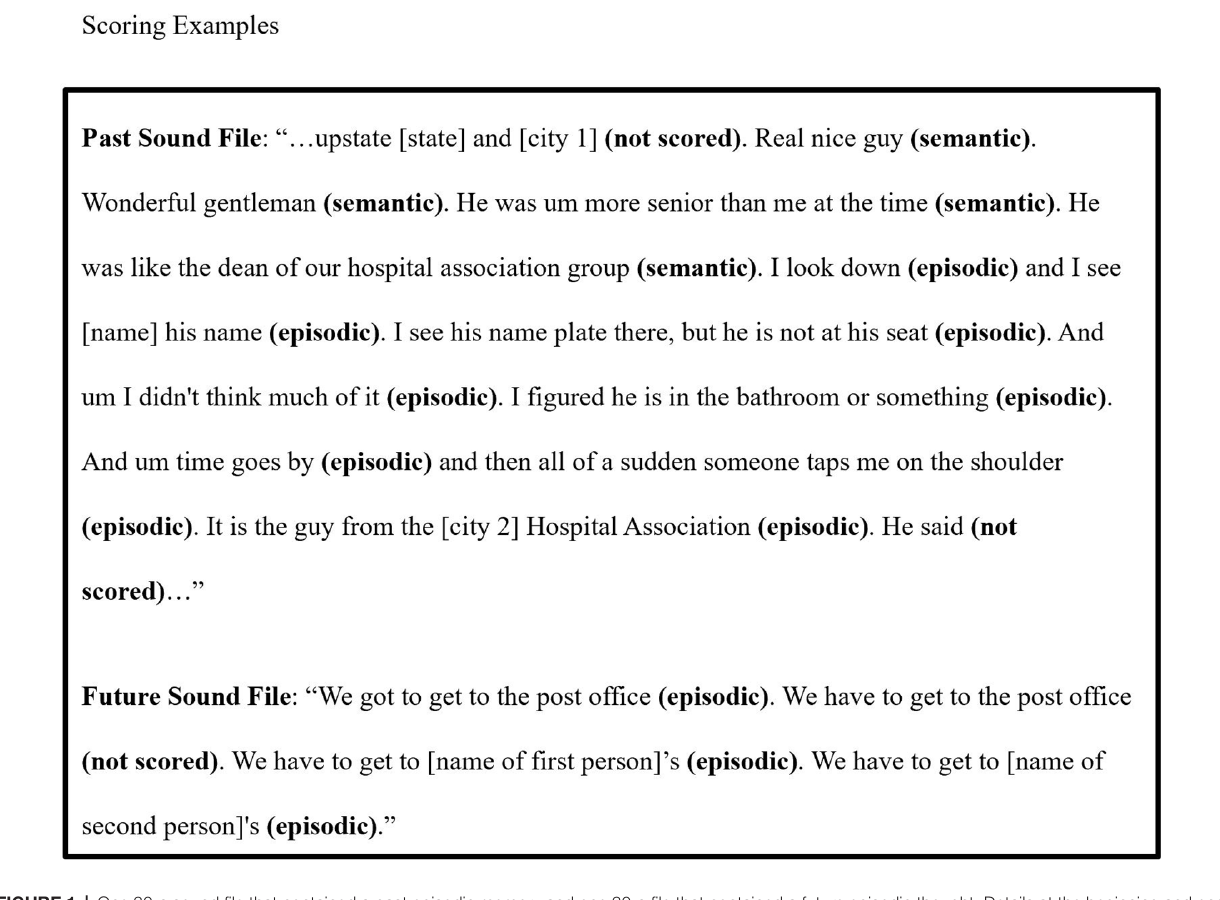
FIGURE 1 | One 30-s sound file that contained a past episodic memory and one 30-s file that contained a future episodic thought. Details at the beginning and end of the past sound file example were not scored because they extended beyond the 30-s recording. In the future sound file example, the second detail was not scored because it was a repetition of the first